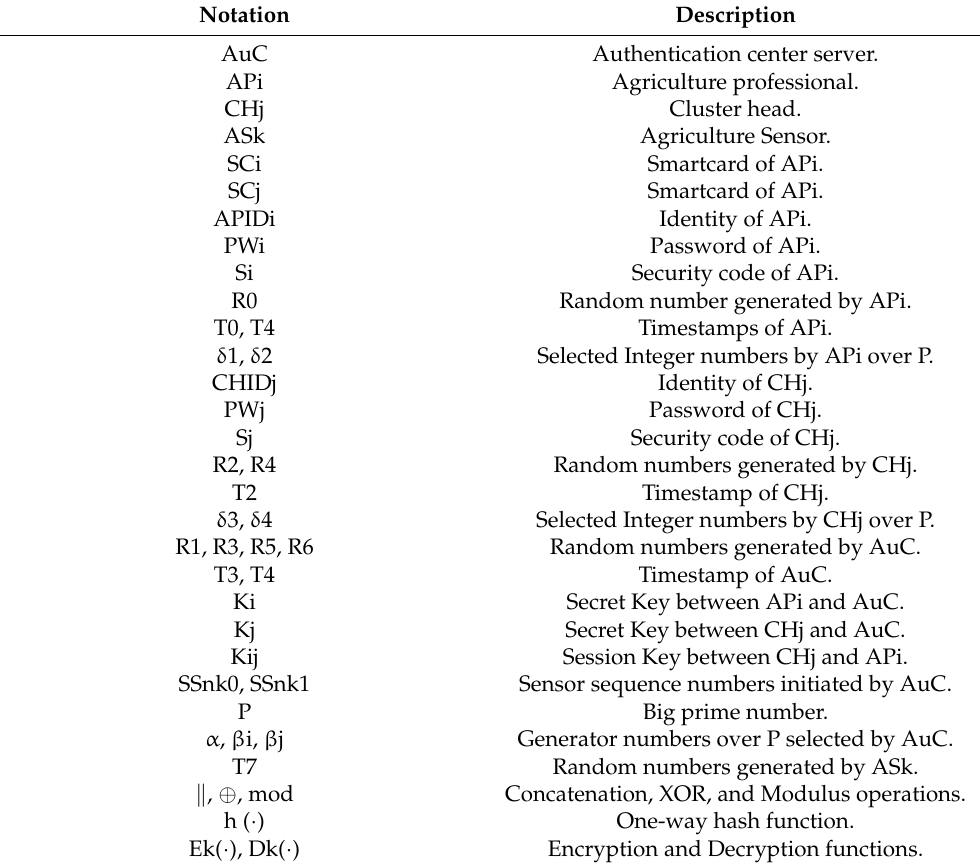
Table 1. Basic notation and